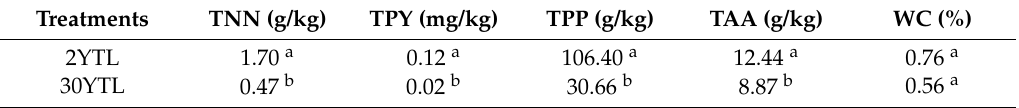
Table 1. Quality parameters of tea leaves from tea plantations of different ages. TNN, TPY, TPP, TAA, and WC represent the anine, theophylline, total polyphenols, total free amino acids, and water content, respectively. 2YTL and 30YTL represent the two-year-old tea field and the 30-year-old tea field leaves, respectively. Different letters ( a and b ) in columns show a significant difference determined by Tukey’s test ( p ≤ 0.05, n = 2).